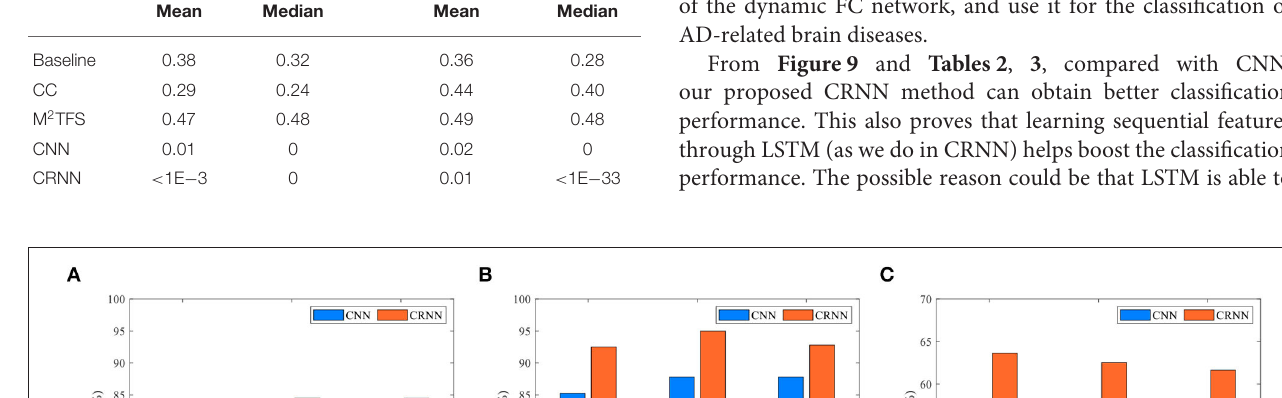
TABLE 4 | The average and median of p -value for learning features in both group pairs (i.e., eMCI vs. NC groups, and AD vs. NC groups). Method